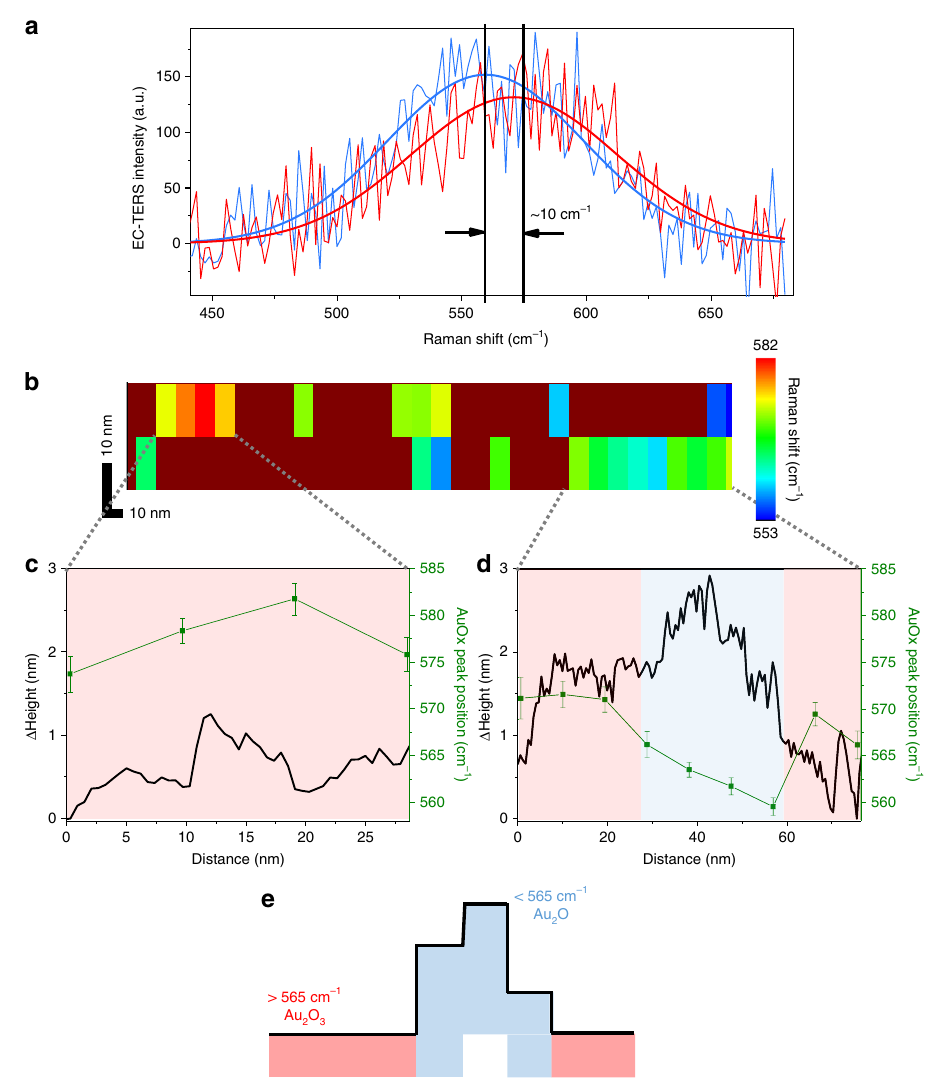
Fig. 4 Nm-resolved chemical nature of AuOx species. a Two example EC-TER spectra (background subtracted) recorded at different AuOx defect locations and corresponding Gaussian peak fi ts, exhibiting a difference in peak position of ~ 10 cm − 1 . b EC-TERS map reconstructed from the AuOx peak position corresponding to the upper part of Fig. 2f. c , d Correlation between Δ height pro fi les and EC-TERS peak positions. The y-error bars represent the standard deviation of the bootstrapping fi tting analysis (see Supplementary Note 6 for details). e Schematic illustrating the difference in AuOx peak position, i.e, in chemical nature, at different locations on the